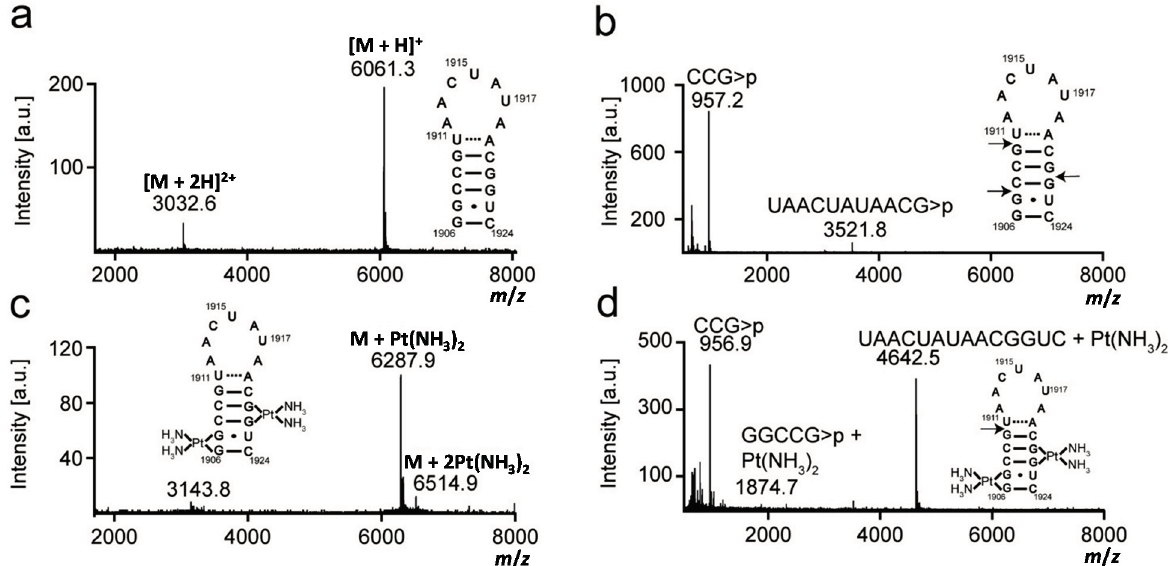
Figure 2. Mass analysis of platinated unmodified H69 is shown. Mass spectra of ( a ) unmodified H69 parent RNA (unplatinated H69); ( b ) RNase T1 digestion of unplatinated H69; ( c ) platinated unmodified H69; and ( d ) RNase T1 digestion of platinated unmodified H69 are given. Arrows indicate RNase T1 cleavage sites.